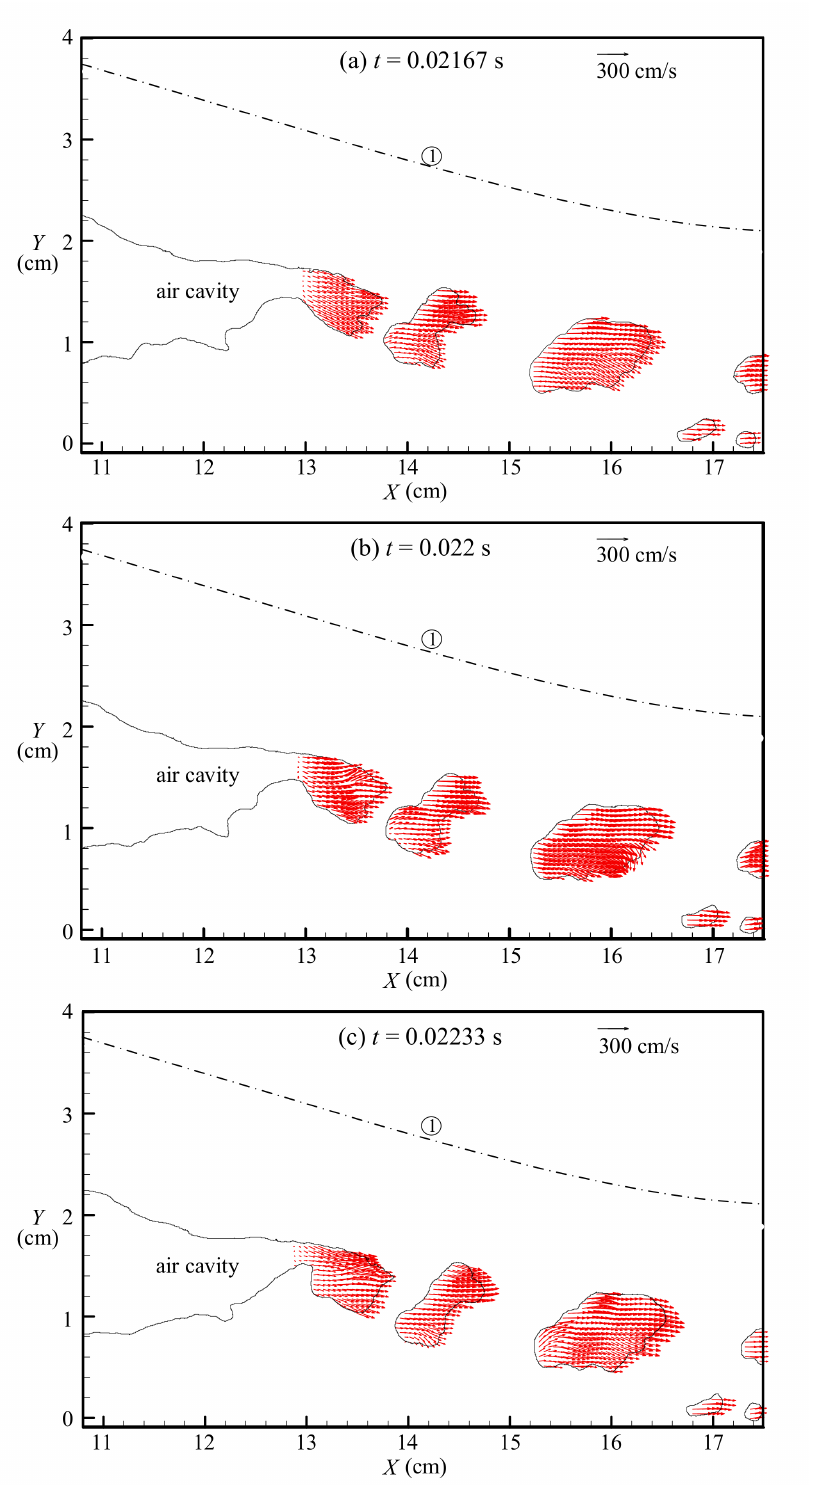
Figure 15. Instantaneous velocity fields of air bubbles at ( a ) t = 0.02167 s; ( b ) t = 0.02200 s; ( c ) t = 0.02233 s using the BIV analysis, along with highlight of the first water–air interface (labeled with 1 (cid:13)